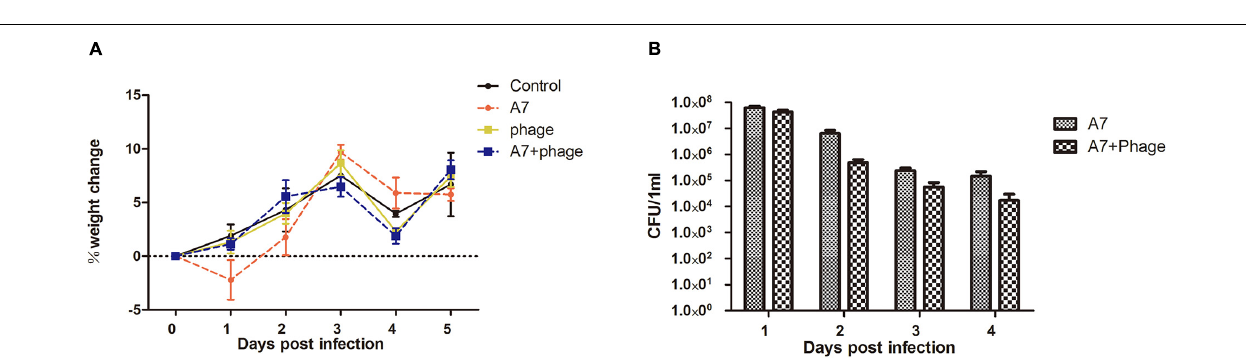
Frontiers in Microbiology |